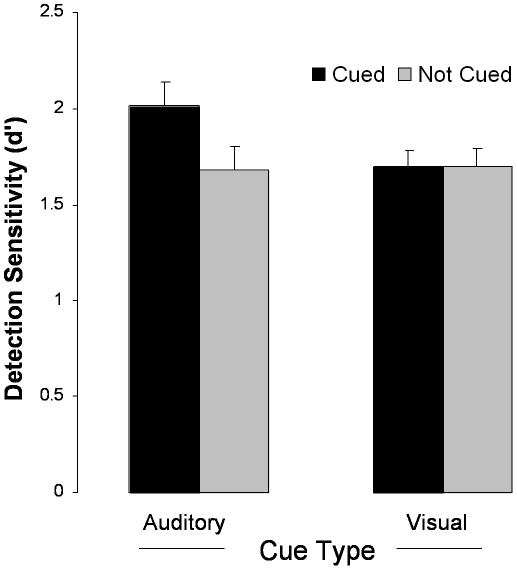
Results from Experiment 1 indicating effects of auditory and visual cues on the detection of cued visual objects.Bars indicate ±1 SE of the difference between the means.